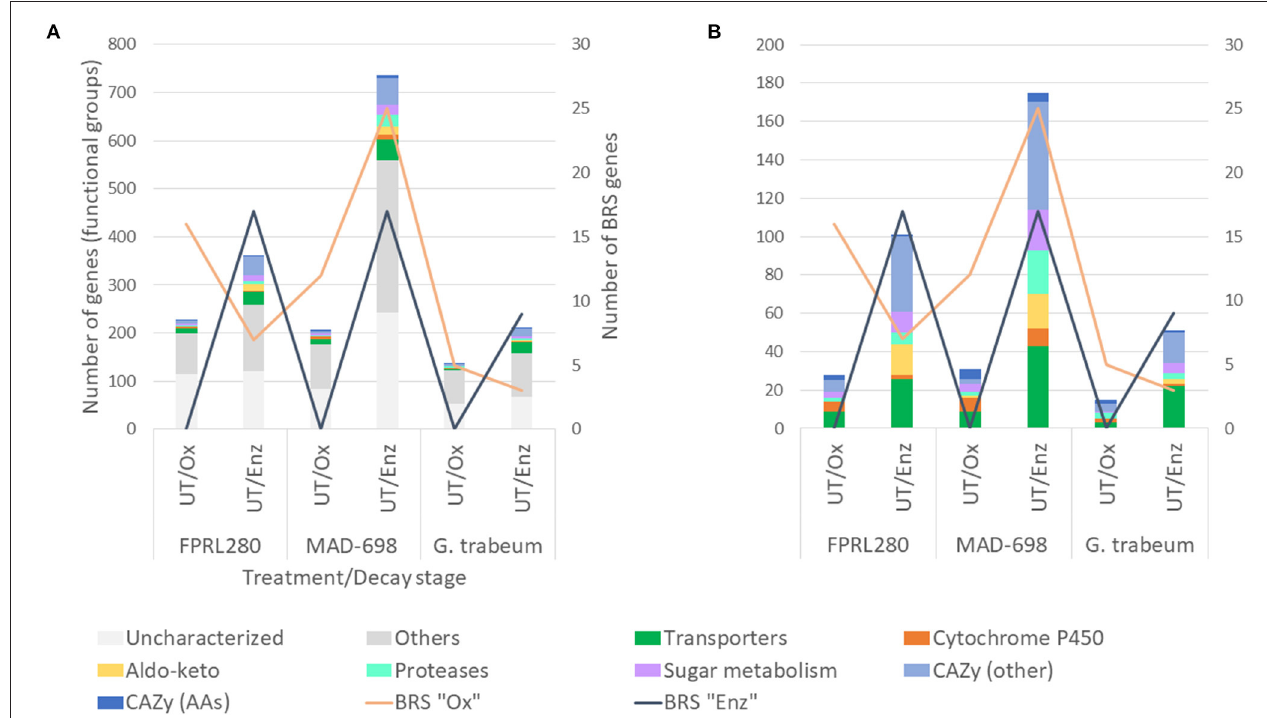
FIGURE 2 | Functional groups of genes significantly upregulated in untreated samples during oxidative and enzymatic brown rot decay. The figure shows the two R. placenta strains used for this study (FPRL280 and MAD-698) and G. trabeum . (A) For the grouping the categories “Transporters”, “Cytochrome P450”, “Aldo-keto” and “Proteases”, genes encoding for enzymes involved in sugar metabolism as well as “CAZy”, “BRS Ox” and “BRS Enz” (brown rot specific) were used. Genes with other functions, as well as uncharacterized genes are also shown. (B) For enhanced readability the categories of “Others” and “Uncharacterized” were exluded.